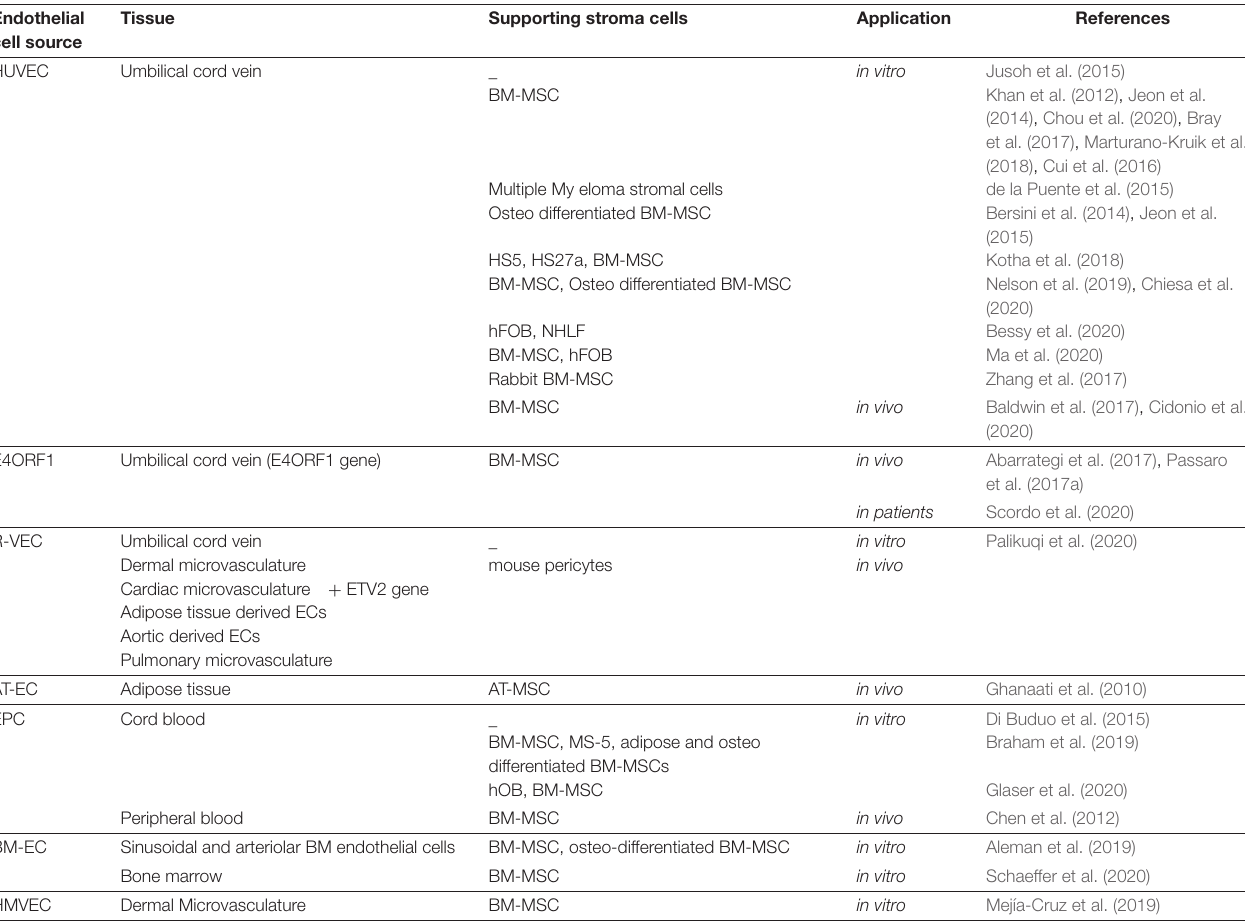
TABLE 1 | Human endothelial cell